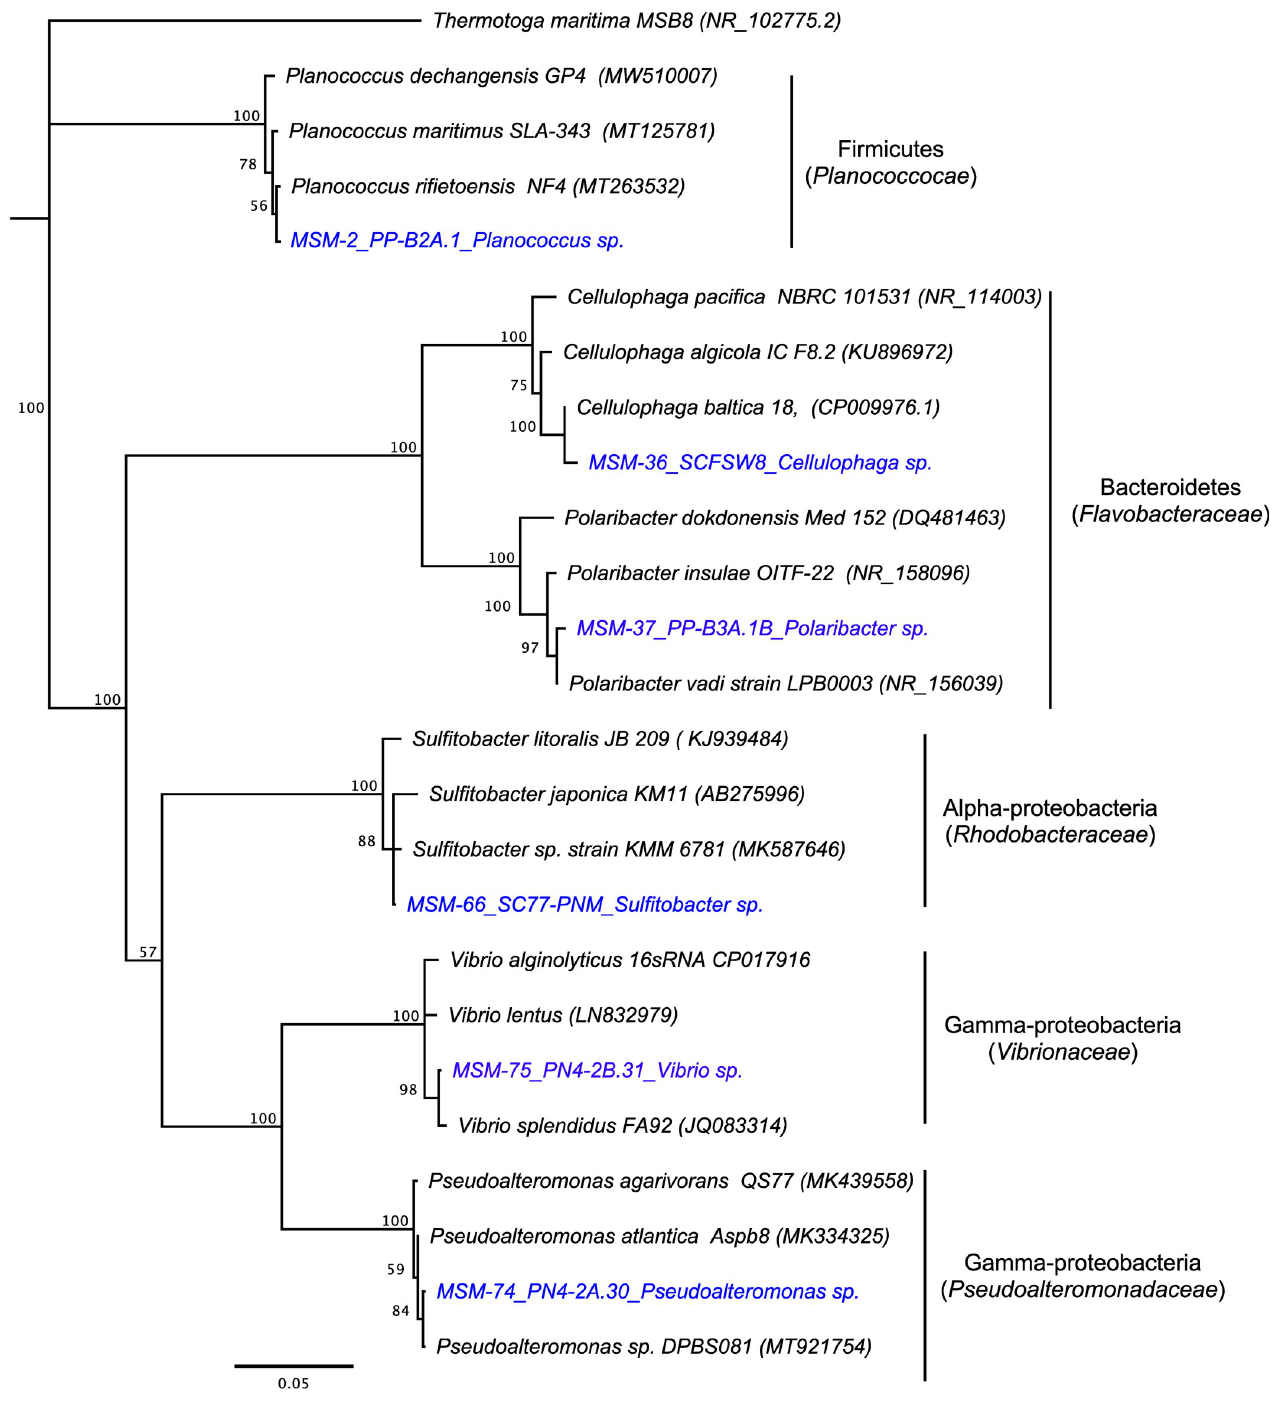
Fig 3. Phylogenetic tree of the bacterial isolates (blue color) in the study using 16S rRNA sequence as molecular marker. The tree was constructed using Neighbor-joining and Jukes-Cantor model for DNA evolution with 1000 bootstraps for tree resampling. Texts in parentheses are accession numbers of 16S rRNA homologous sequences downloaded from